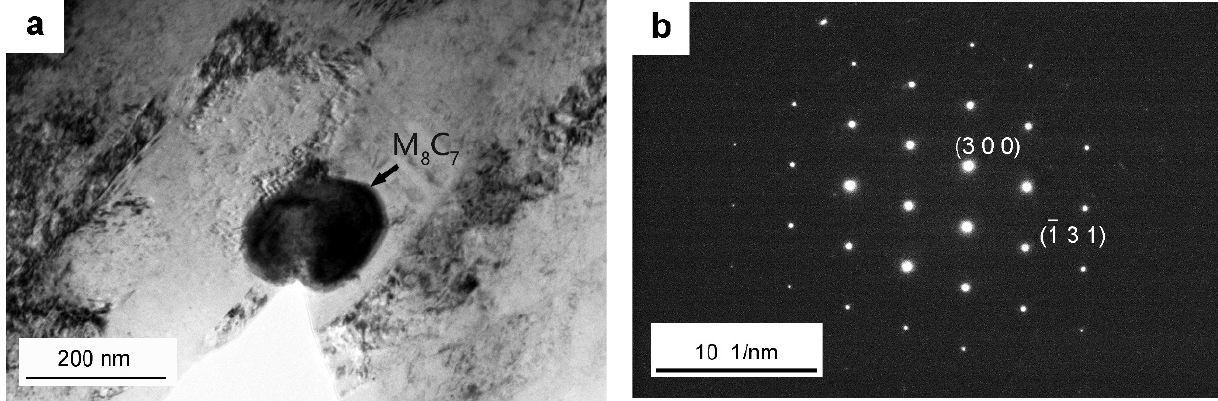
Figure 2. TEM images showing larger spherical carbides, lath martensite, and lenticular martensite after quenching at 1030 °C in Dievar steel: ( a , c ) bright field images of a typical larger spherical carbide; ( b ) SAD pattern for the particle in ( a ) consistent with the [3 − 9 1] zone axis of M 8 C 7 ; ( d ) EDS spectra for the particle in ( c ) , indicated by the white arrow; ( e ) lath martensite; ( f ) lenticular martensite. 3.2. Microstructure Evolutions during Tempering As shown in Figure 3a–h, martensite is then recovered, and the lath structure is regenerated and recrystallized during tempering at different temperatures with the extension of duration. As listed in Table 3, the coarsening of laths occurs more